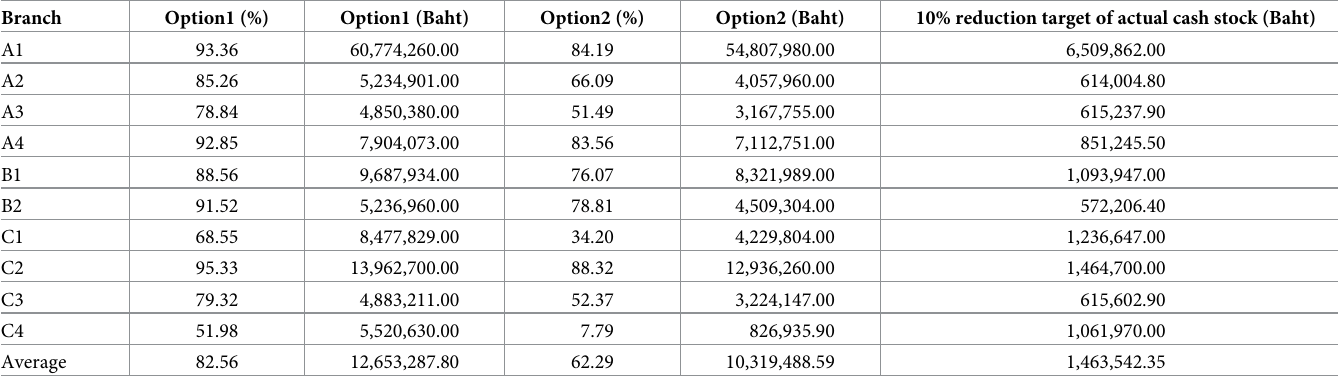
Table 14. Amount of cash stock of various options and 10% reduction target using the entire period data.